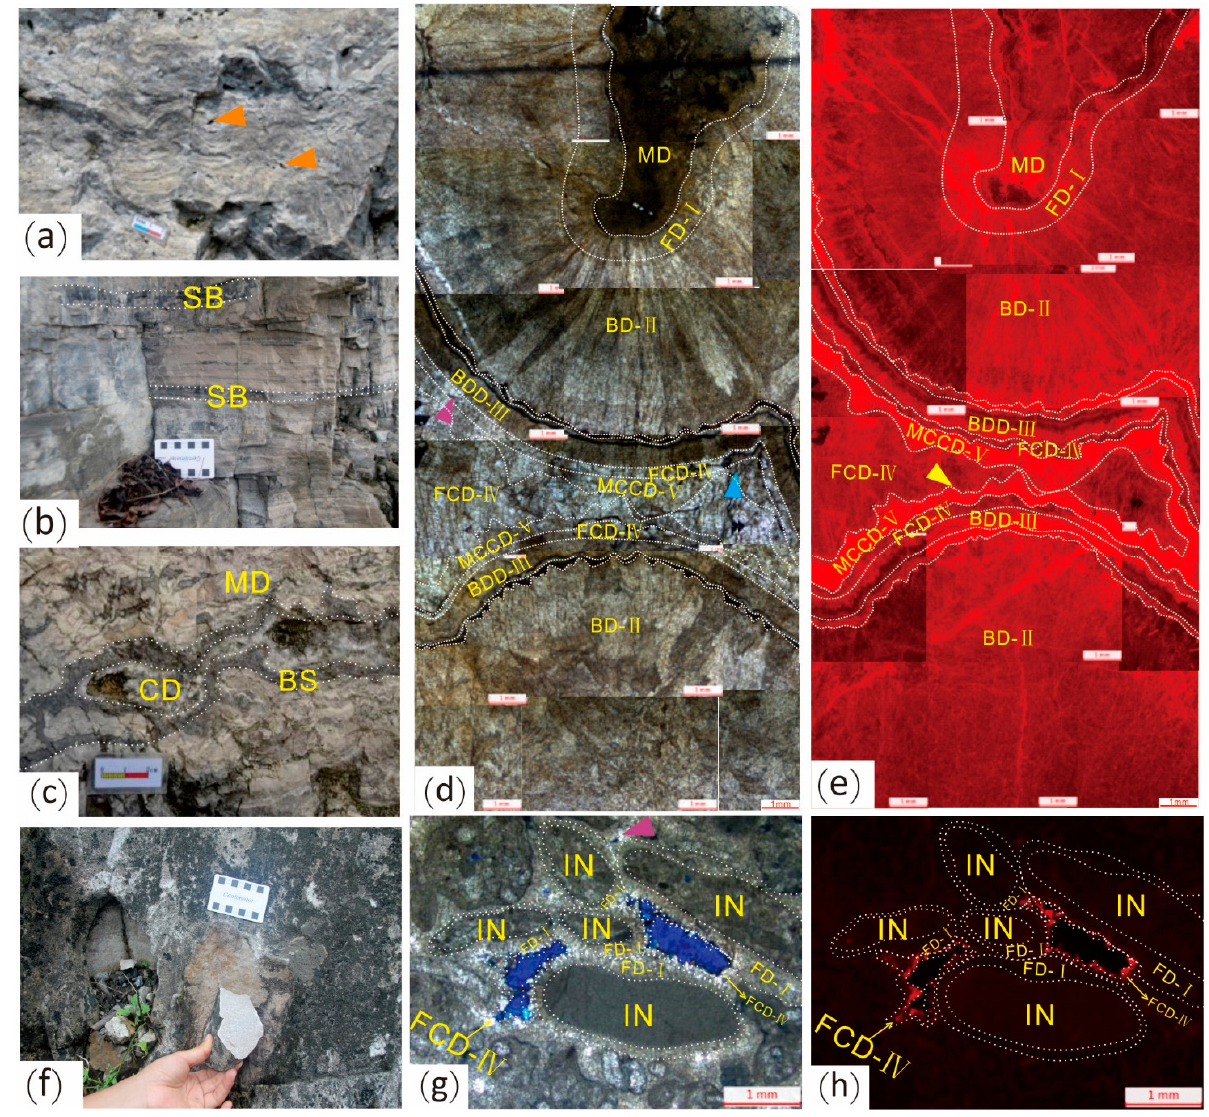
Figure 4. Petrographic characteristics of the microbial dolomite in the Dengying Formation, Eastern Sichuan. ( a ) Outcrop image, the 4th Member in the Bajiaoxi profile, stromatolite dolostone, with well-developed dissolution pores (by orange arrows); ( b ) Outcrop image, the 4th Member in the Bajiaoxi profile, laminated dolomite, with the development of siliceous layers (SB); ( c ) Outcrop image, the 2nd Member in the Hanfengya profile, showing sequence of thrombolite dolostone (MD), botryoidal structure (BS), and crystalline dolomite (CD), and their relationship to large vuggy porosity; ( d ) Microscope image of botryoidal dolomite (Sample HF-Dn1) from the 2nd Member in the Hanfengya profile merged by 13 views, showing petrological appearance of the host rock (MD) and vugs filled with five stages of dolomite cement defined in this study; ( e ) the emerged CL images of ( d ), yellow arrows indicate the rim structure; ( f ) Outcrop image from the 4th Member in the Bajiaoxi profile showing the intraclastic bindstone to grainstone; ( g ) Thin section image from the 4th Formation in the Bajiaoxi profile (Sample BJ-Dn4), which consists of intraclastic bindstone to grainstone, displaying various types of intraclasts (IN), cements, and interparticle pores (blue impragnate); ( h ) the CL image of ( g ).